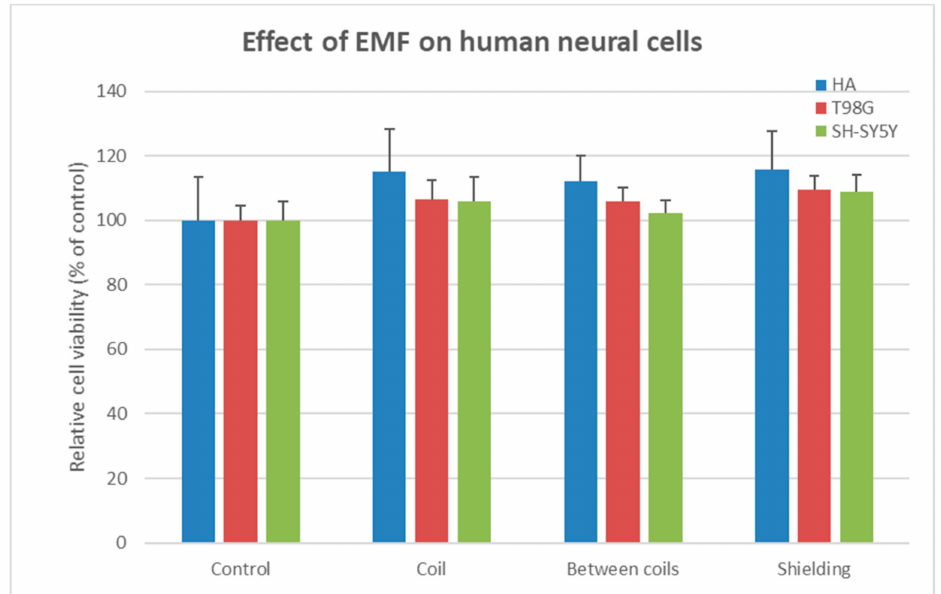
Figure 11. Effect of EMF on cell viability of HA, T98G and SH-SY5Y analyzed by MTT assay. Cells were exposed to 87 kHz for 30 min and then regenerated for another 44 h at standard cultivation conditions. The control group represents 100% viability. Data are mean ± SD. Data are representative of three independent experiments with 12 replicates